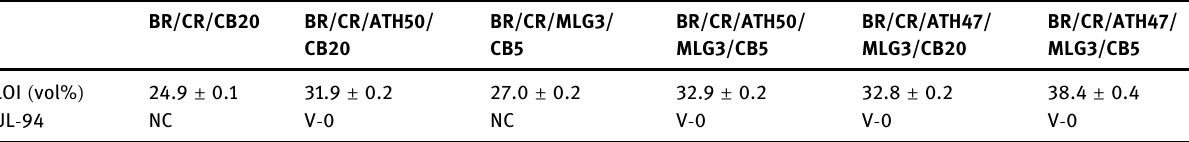
Table 5: LOI and UL - 94 results for BR/CR